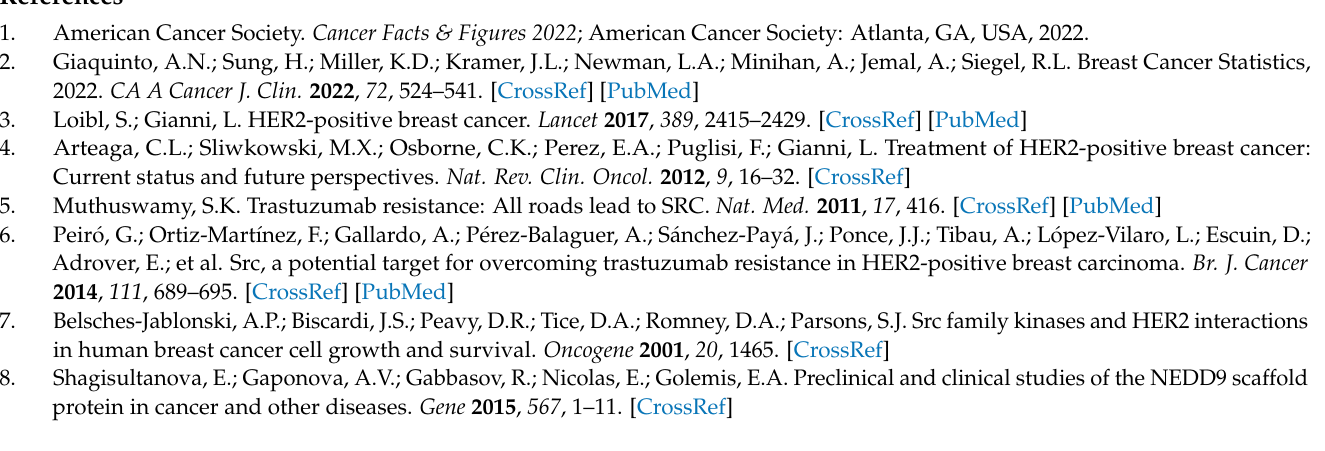
Supplementary Table S1: Tissue pathology and diagnosis used in Figure